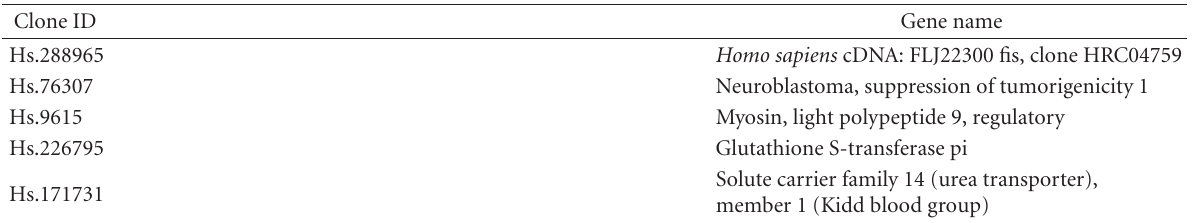
Table 2. List of genes underexpressed in prostate cancer relative to benign prostate